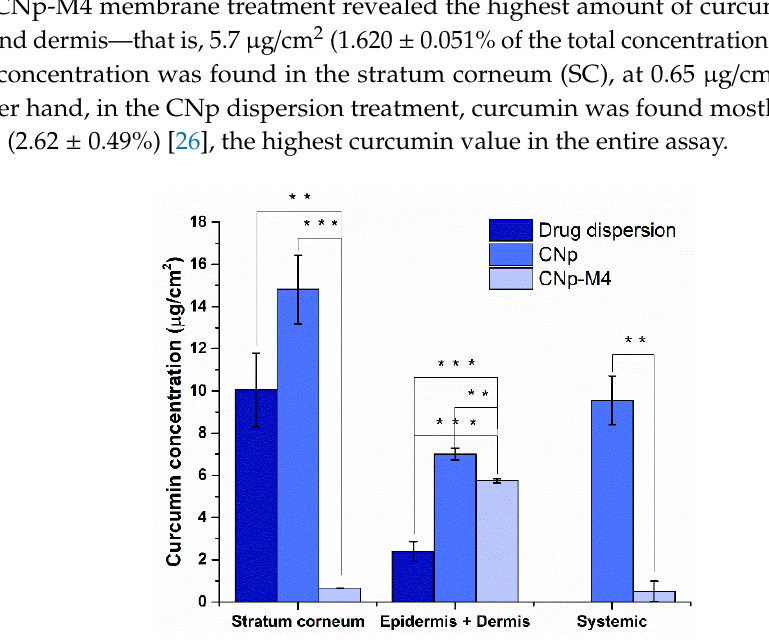
Figure 8. Ex vivo permeation of curcumin after 30 h of treatment with drug dispersion, CNp dispersion, or CNp-M4 membrane. Stratum corneum-bound particles (obtained from 15 tape strips), epidermis + dermis (surface on which dosed skin was handled after 30 h), and systemic (receptor compartment), mean ± SE, n = 4; ** indicates p < 0.01 and *** indicates p < 0.001 as statistically significant.